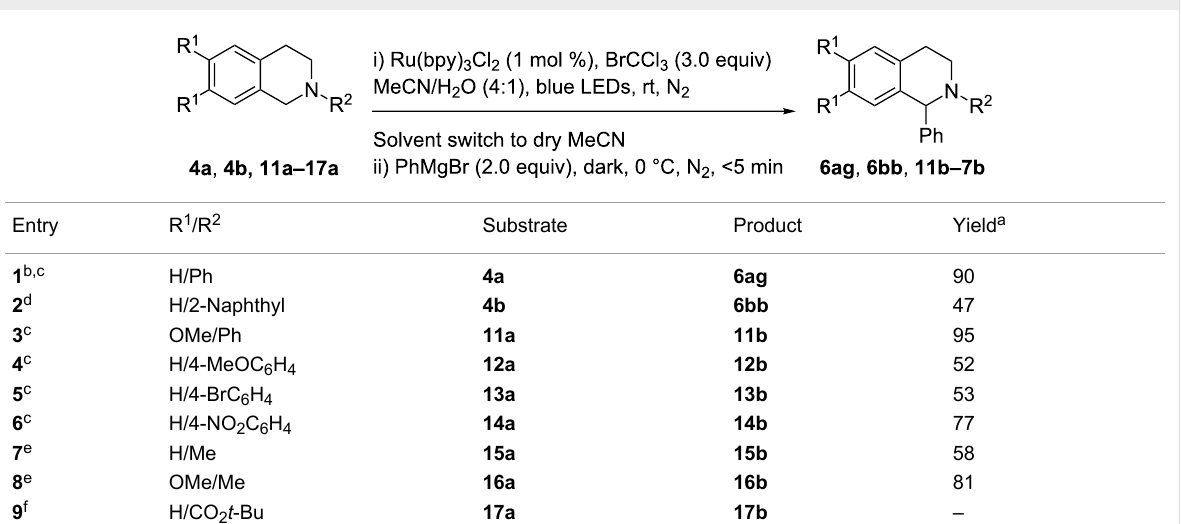
Table 2: Substrate scope of organometallic additions to iminium salts generated via visible-light photoredox